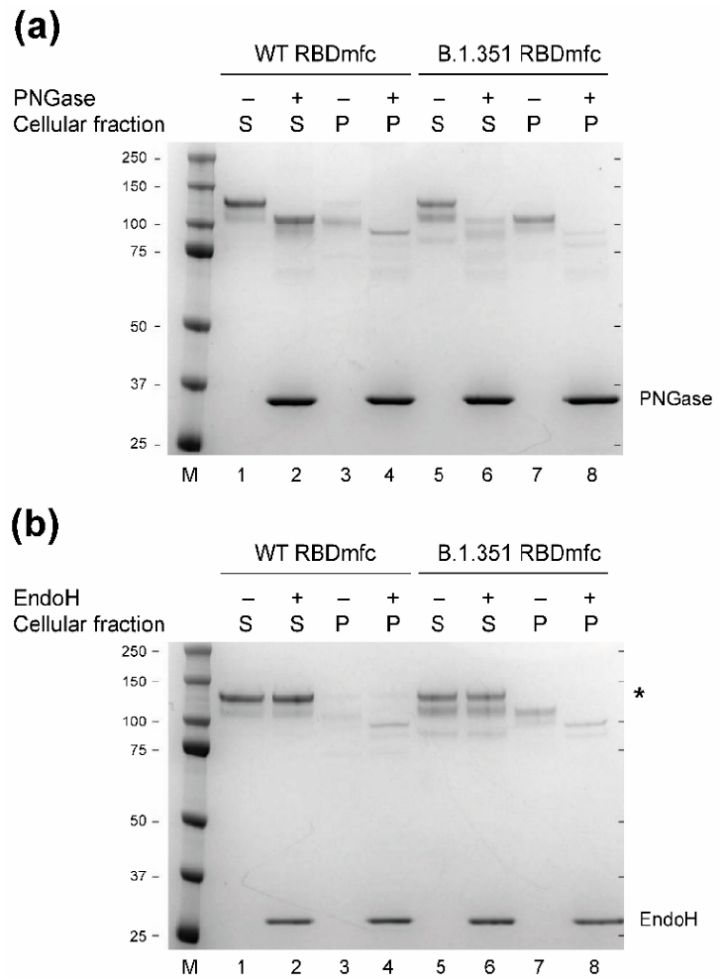
Figure 5. SDS-PAGE and Coomassie staining of purified RBDmfc proteins (S, secreted in culture medium; P, lysate from cell pellet, representing the intracellular fraction) before and after deglycosylation by PNGase ( a ) or EndoH ( b ). M, protein ladder (apparent MW in kDa indicated on the left); *, upper MW form (apparent MW of 120 kDa). Uncropped SDS-PAGE images are shown in Appendix A Figure A2.